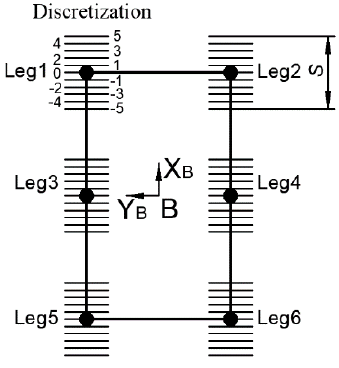
Figure 6. Discretization of foot positions on the ground.